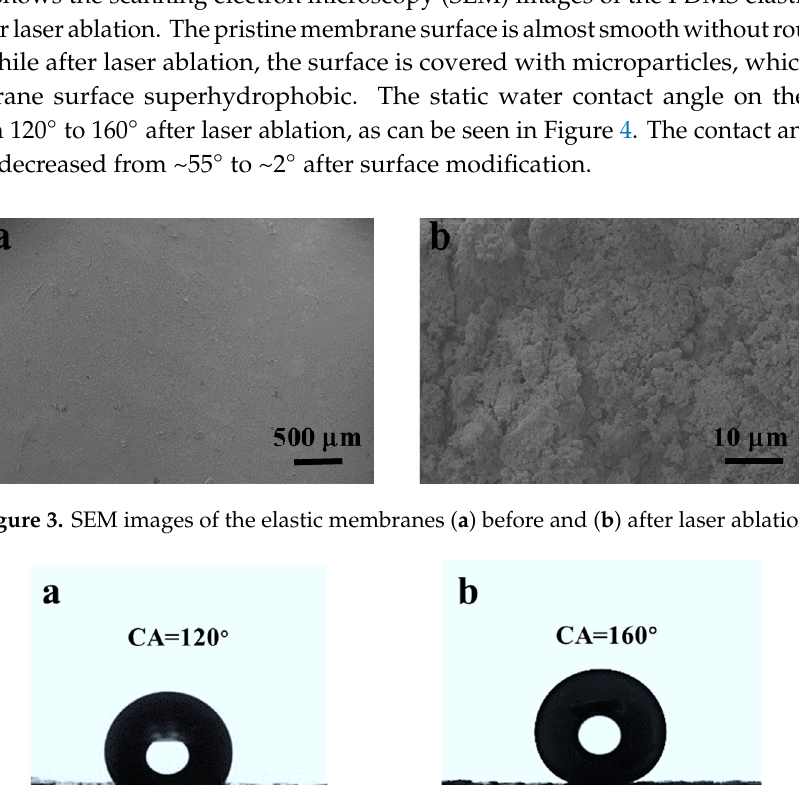
Figure 2. Experimental setup of droplet impacting on the cold elastic superhydrophobic membrane.